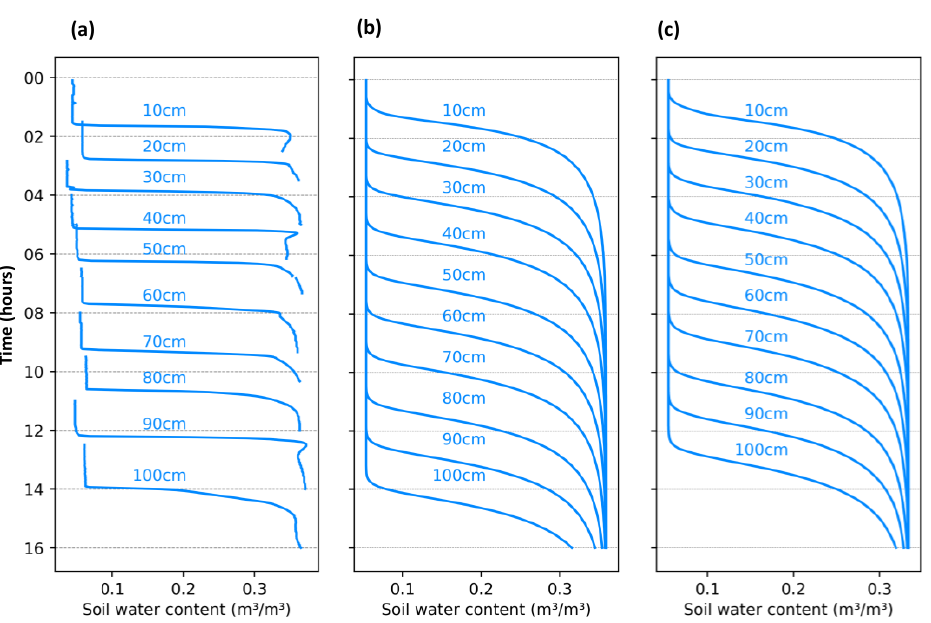
Figure 11. ( a ) Soil water content measured by sensors and simulated through the ( b ) Hydrus model before and ( c ) after its calibration for the soil column.